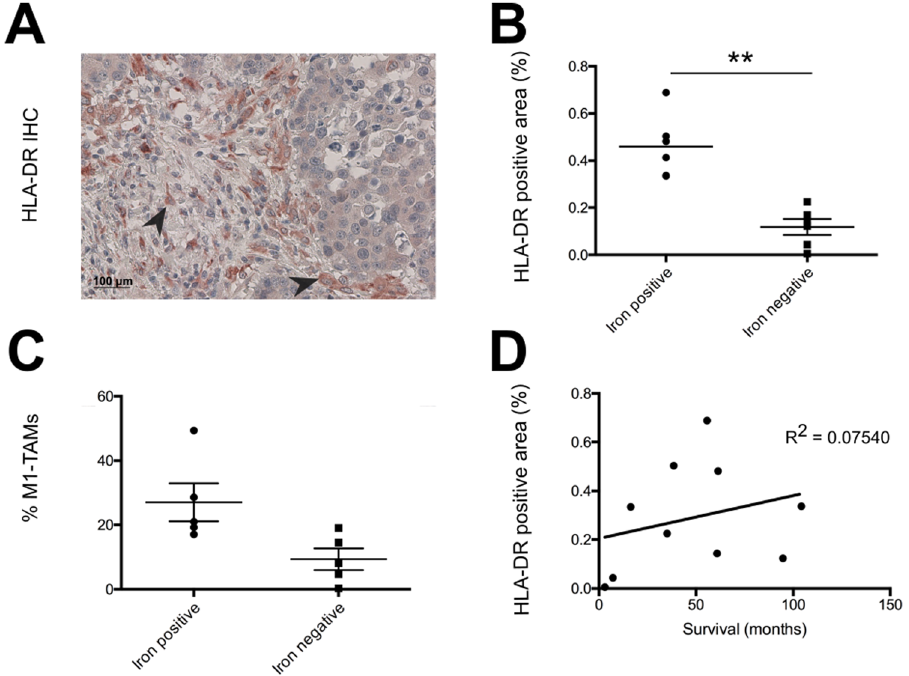
Figure 5. Iron positive samples of adenocarcinoma show more HLA-DR + macrophages. ( A ) Example of HLA-DR staining with arrowheads indicating positive staining. ( B ) Comparison of the two groups of the samples with the highest content of HLA-DR + macrophages. Iron positive (n = 5) and iron negative (n = 5) were compared. ( C ) Relative M1 TAM content amongst total TAM numbers for iron positive (n = 5) and iron negative (n = 5) samples. ( D ) Linear regression of iron content and HLA-DR + positive macrophage content. Statistical tests performed are Mann-Whitney U test and linear regression. Data is shown as mean ± SEM. * p < 0.05, ** p < 0.01, *** p < 0.001, **** p <